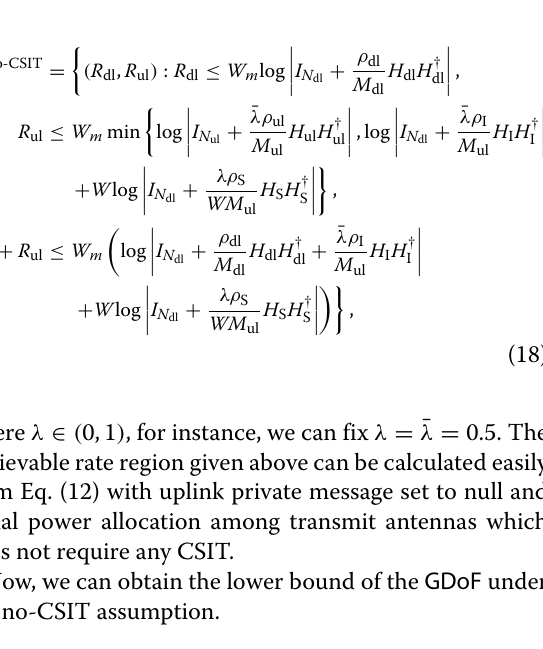
We first describe the encoding and decoding strategy under the no-CSIT assumption. Both transmitters encode their messages using independent Gaussian codebooks for the main-channel. The uplink transmitter sends common message only and applies vector bin-and-cancel scheme. The side-channel bins all the uplink message and encodes the bin indices using an independent Gaussian code- book. From the downlink user’s perspective, the channel is a MAC with side channel. At the decoding process, the downlink user uses joint maximum likelihood